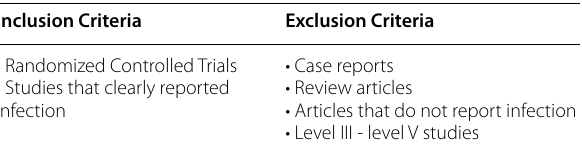
Table 1 Eligibility